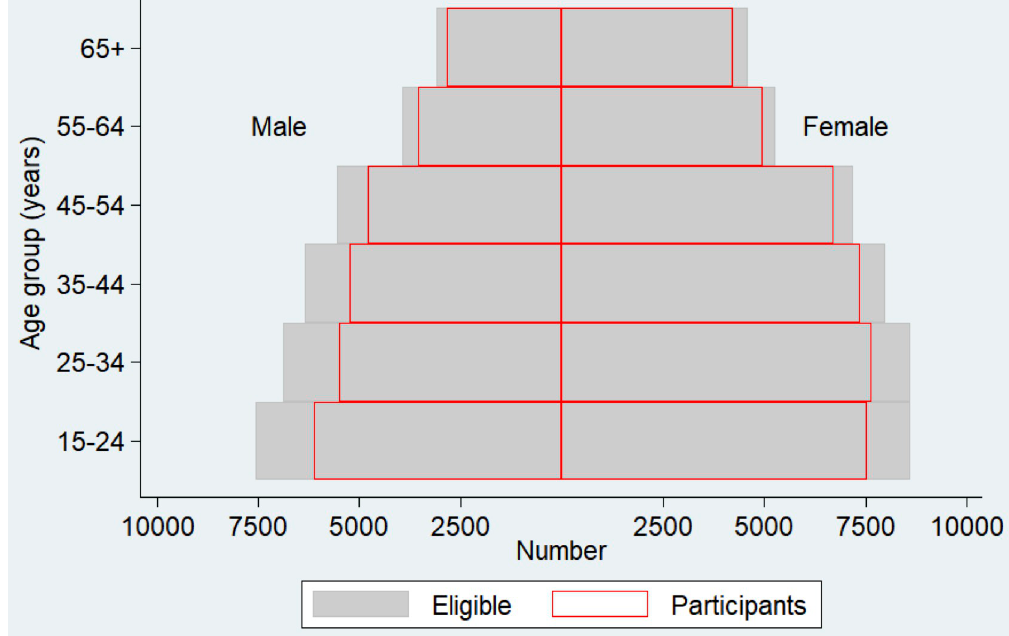
Fig 3. Comparison of age-sex distribution for the eligible and participated